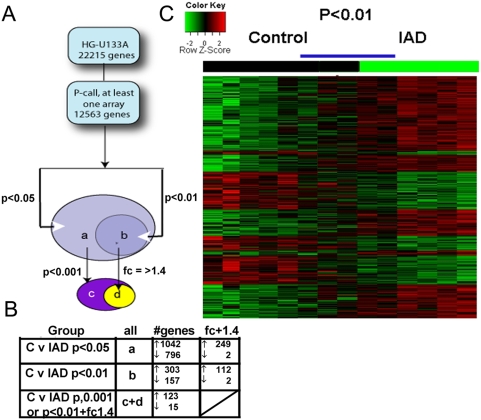
Microarray and Cluster Analysis.In A) Genes were filtered out on the “present” call (P-call) generated by MAS 5.0 leaving 12,536 genes. A 2-way ANOVA test performed on log10-transformed data comparing control with IAD detects the significantly expressed genes. Changes in gene expression in the IAD patients were evaluated at 3 levels of significance (p<0.05, p<0.01, p<0.001) for patients grouped by MMSE values and summarized in the chart below, B). We used the p<0.01 analysis gene list for further study. In C), cluster analysis shows relative mRNA message in controls (black bar) and IAD patients (green bar) with increased expression (green to red) or decreased expression (red to green). Blue line above the heatmap encompasses patients with gene profiles transitional between control and IAD. See Table S2 for genes lists with gene name, symbol and fold change.